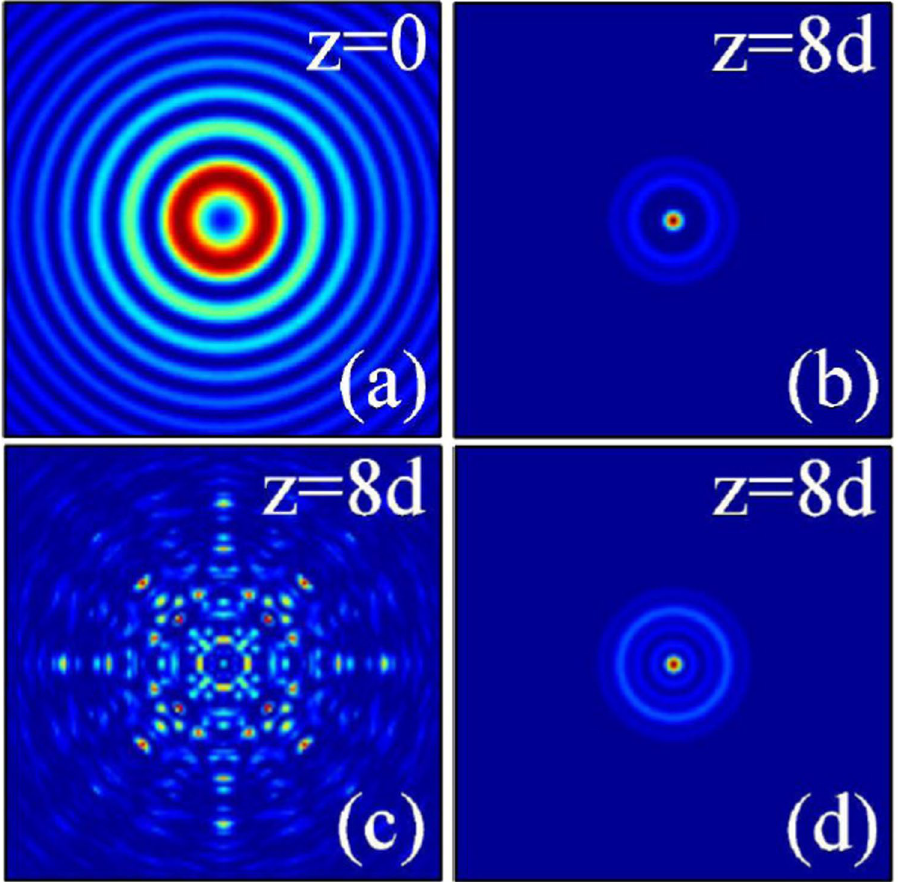
Figure 6. The intensity distributions of inward accelerating abruptly autofocusing Airy beam at different propagation distances in ( a – c ) local ( σ = 0), and ( d ) nonlocal nonlinear media, respectively. The initial parameters are m = 0, r 0 = 0.5, A = 1 ( a , b ), and A = 12 ( c , d ). The degree of nonlocality of Fig. 6(d) is σ =